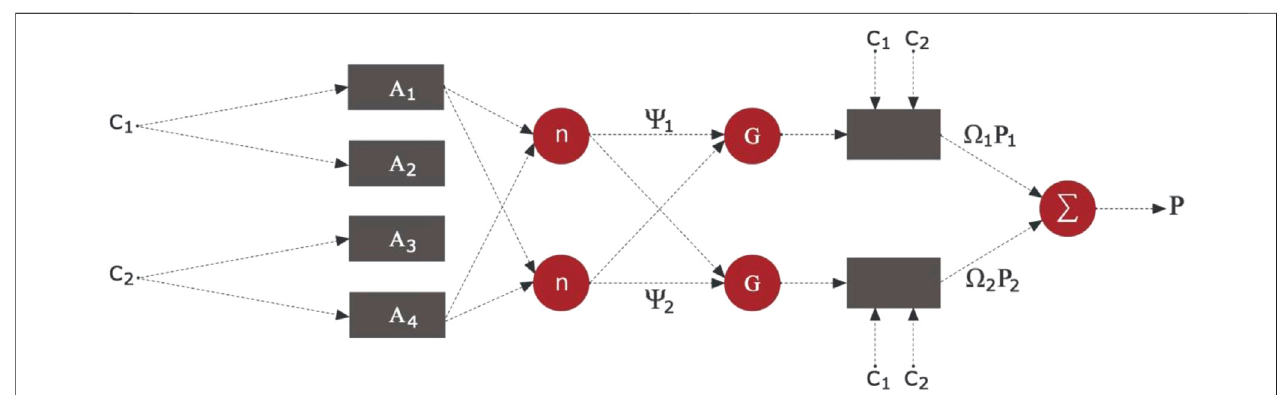
FIGURE 2 | Structure of the ANFIS model (Ramezanizadeh et al., 2019c).